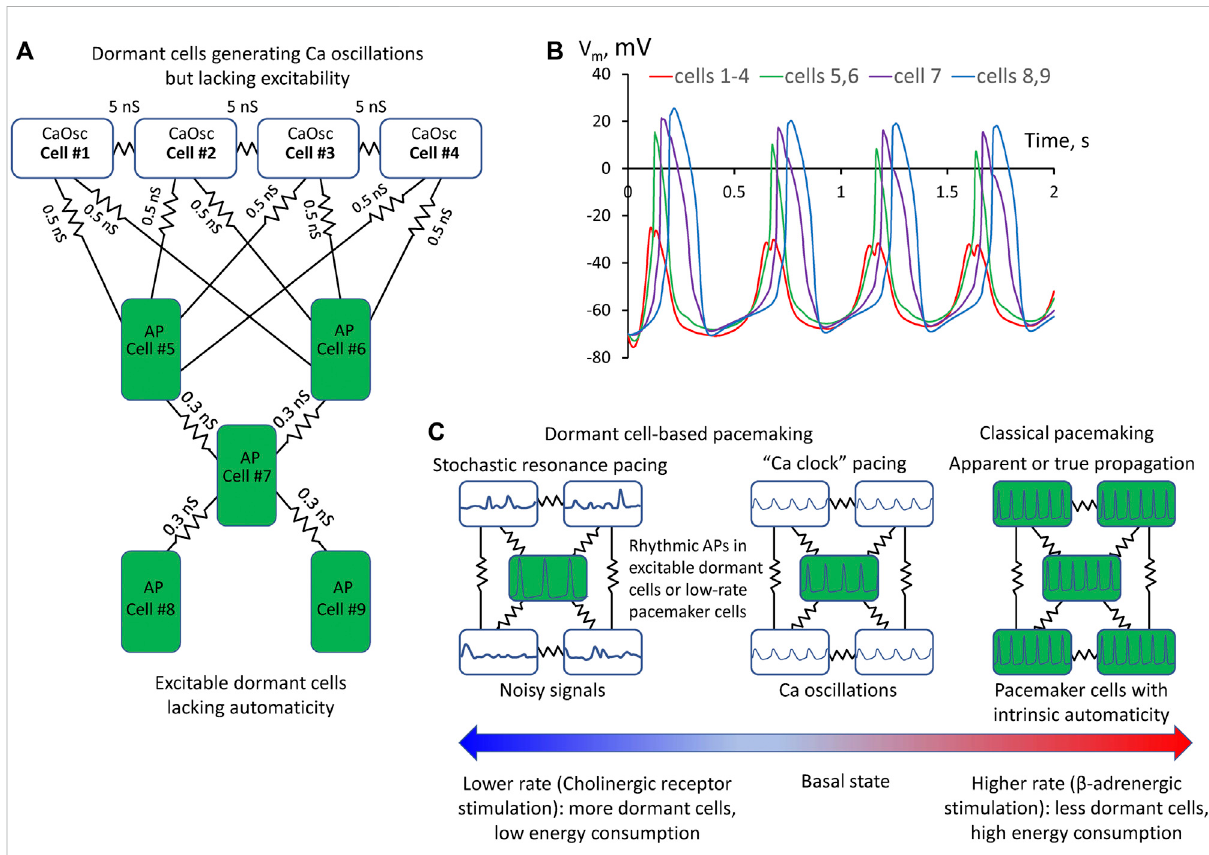
A more complex model of pacemaker network of nine dormant cells demonstrating that Ca oscillator cells can drive more than one excitable cell and theemergent automaticity can spreadwithin further layers of dormant excitablecells. (A) A diagram of the network: cells #1 – 4 operating as Caoscillators(CaOsc)and excitable Cells#5 – 9(i.e.,AP capablecells, labelledas APC) arelooselyconnected(zigzag lineswith conductance values). (B) V m time course in the cells of the network. V m rise in cell #1 always preceded AP upstrokes in excitable cells. APs in the three layers of excitablecellsappearwithrespectivedelaysre fl ectinginteractionswithing excitable celllayers. (C) Prevalenceofproposedpacemakingmodes with respect to AP fi ring rates and autonomic modulation state: Stochastic resonance pacing prevails at low rates and cholinergic receptor stimulation, but Ca clock pacing and pacemaker cell pacing prevail in basal state and during β -adrenergic